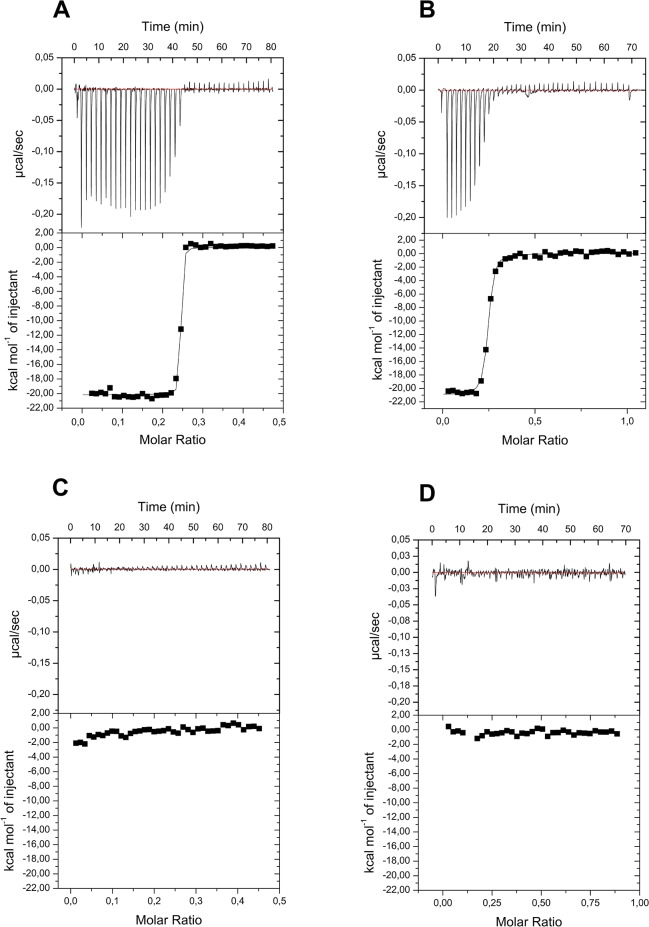
Quantification of Cul3-KCTDs binding by Isothermal Titration Calorimetry.ITC experiments were performed by titrating KCTD6BTB (A), KCTD11BTB (B), KCTD12BTB (C) with Cul3NTD. For KCTD15BTB the ITC experiment was reversed by titrating Cul3NTD with KCTD15BTB (D). The top and bottom panels report raw and integrated data, respectively.